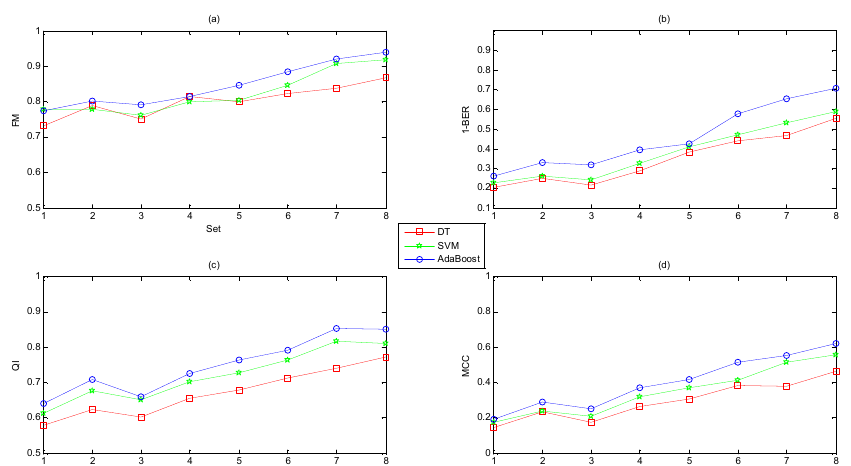
Figure 8. Comparison of the averaged performance evaluation indicators using different feature subsets based on three classifiers across ten folds. The x‐axis shows Set_1, Set_2, Set_3, Set_4, Set_2 + Set_3, Set_1 + Set_2 + Set_3, Set_2 + Set_3 + Set_4, and Set_Complete.